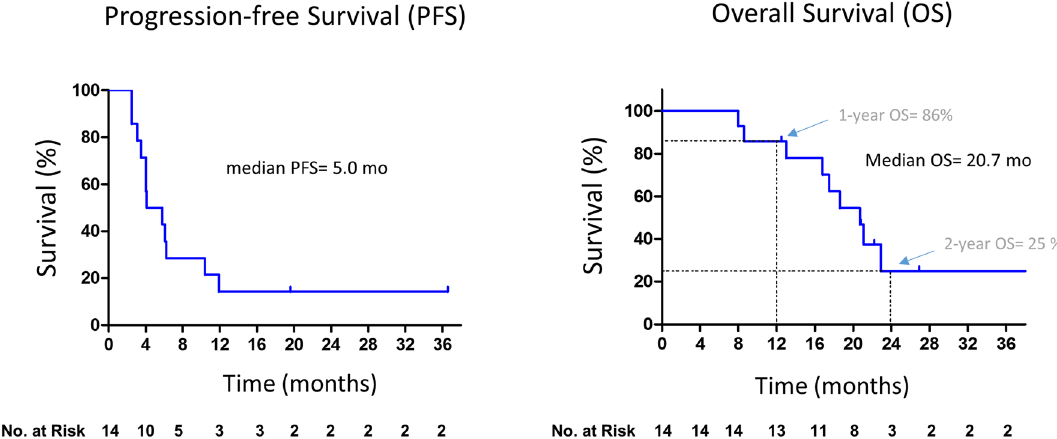
Figure 2. Progression-free and overall survival of patients. Kaplan–Meier survival curves showing progression- free survival (PFS) and overall survival (OS) of